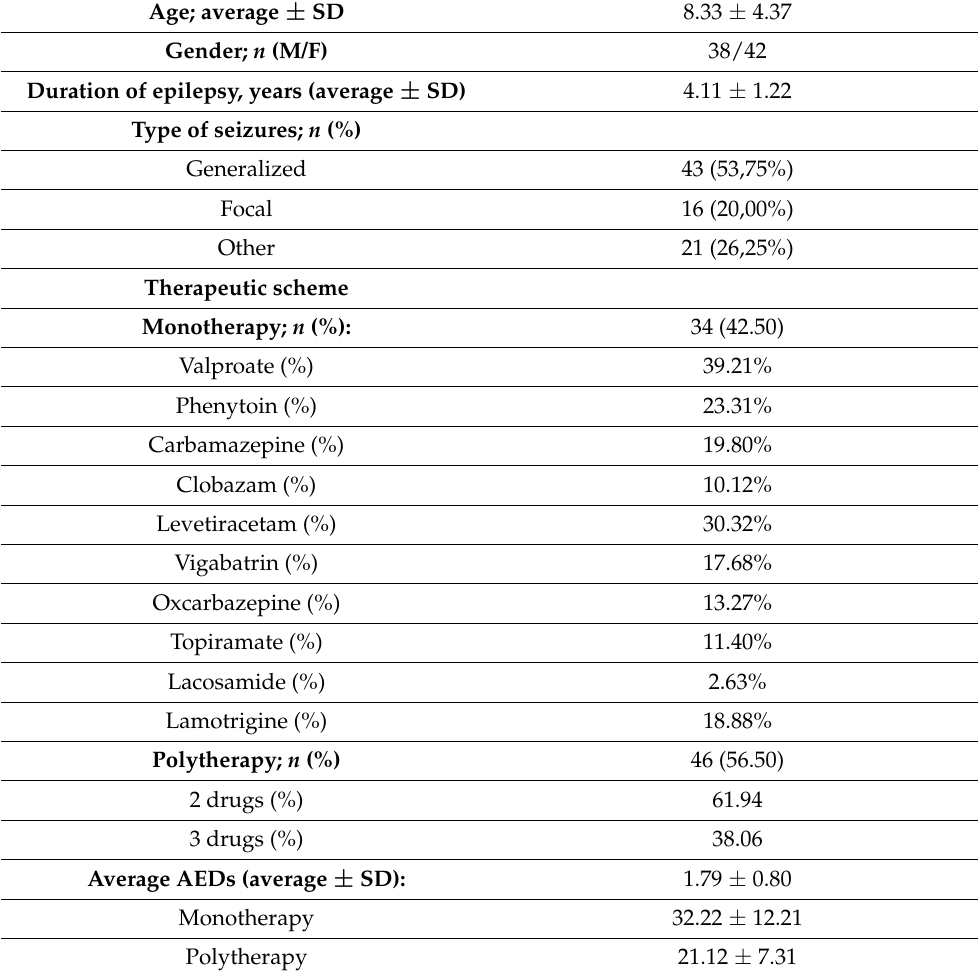
Table 1. Demographic and clinical data (at